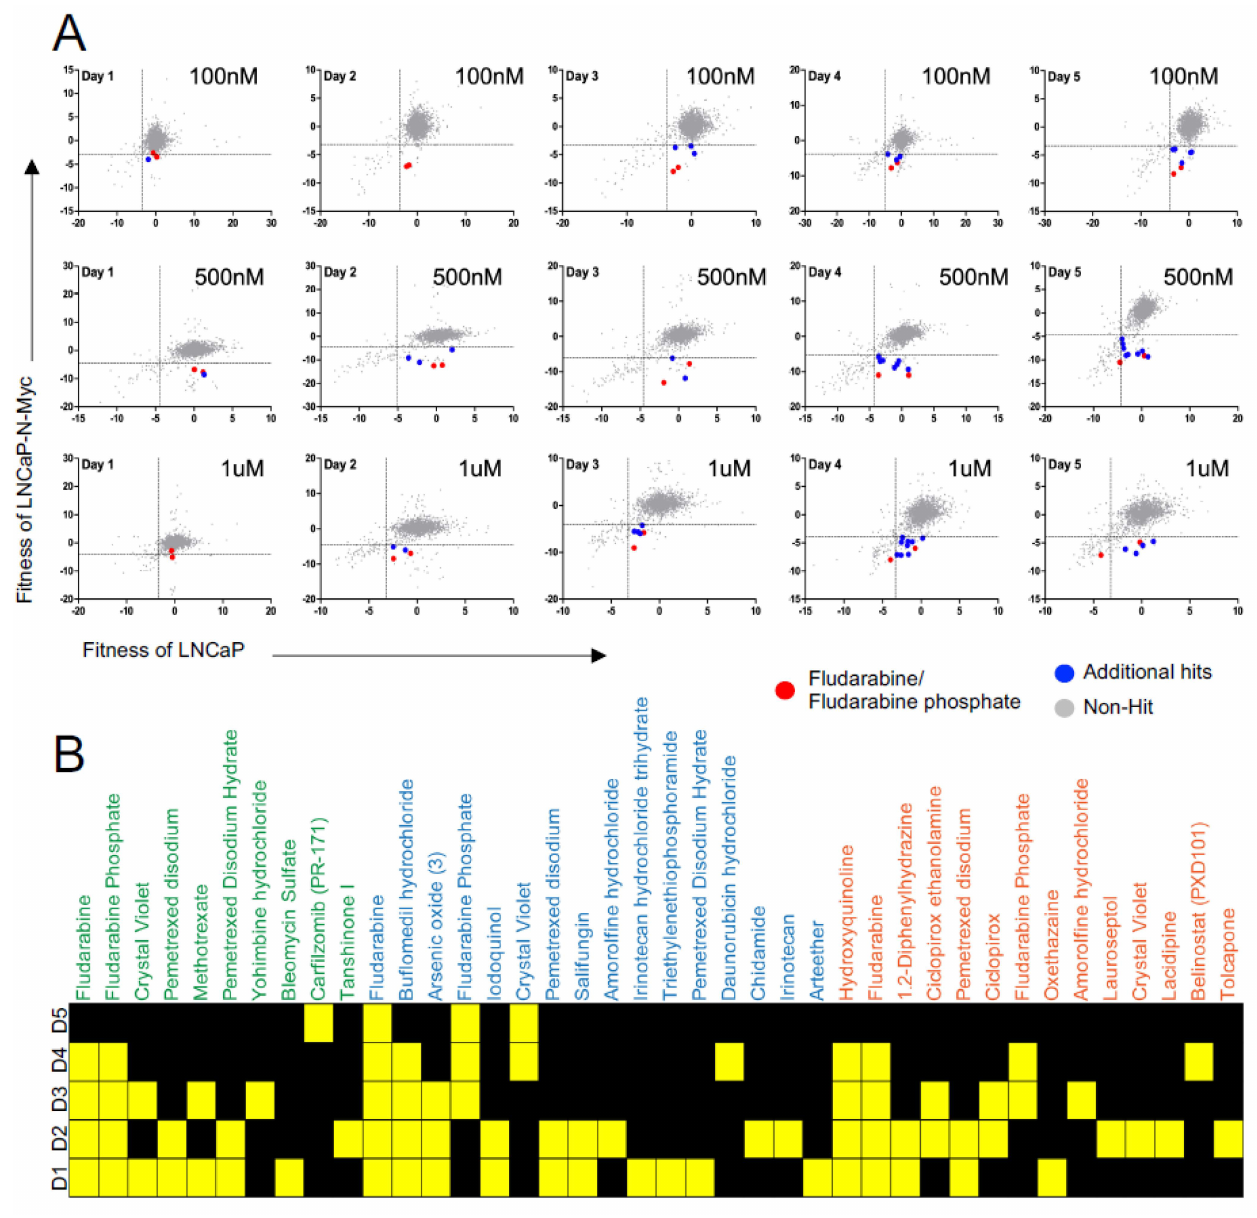
Figure 2. High-throughput drug library screen identified potential lead compounds that selec- tively inhibits proliferation MYCN overexpressing cells. ( A ) Scatter plot graphs show that fludara- bine/fludarabine phosphate is a lead compound eliminating MYCN overexpressing cells. FDA- approved drug library compounds were applied at three different concentrations: 100 nM top panel, 500 nM middle panel, and 1 mM bottom panel to LNCap ( x -axis) and LNCap-N-Myc ( y -axis) cells and the cells were monitored for five days using high content imaging. Fludarabine/fludarabine phosphate red dots, additional hits blue dots, and non-hit grey dots. ( B ) Heatmap plot shows flu- darabine and fludarabine phosphate exhibit preferential inhibition of LNCap-N-Myc cells at 100 nM, 500 nM, and 1 mM concentrations over five days (D1, D2, D3, D4, and D5). Yellow squares represent the days, where significant differences were identified. Hits in green text at 100 nM, hits in blue text at 500 nM, and hits in orange text at 1 mM ( p <